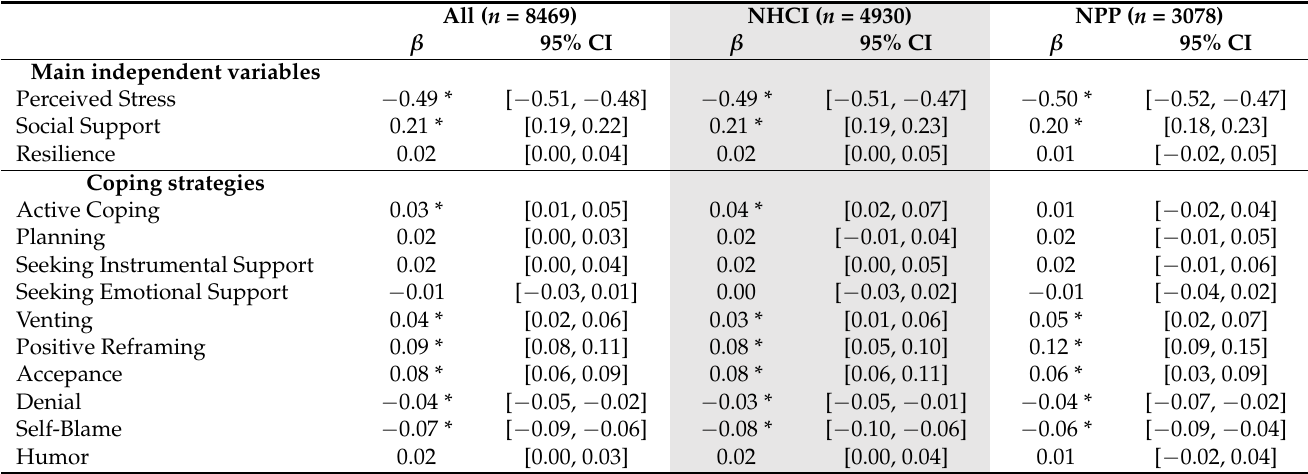
Table 3. Association between variables and quality of